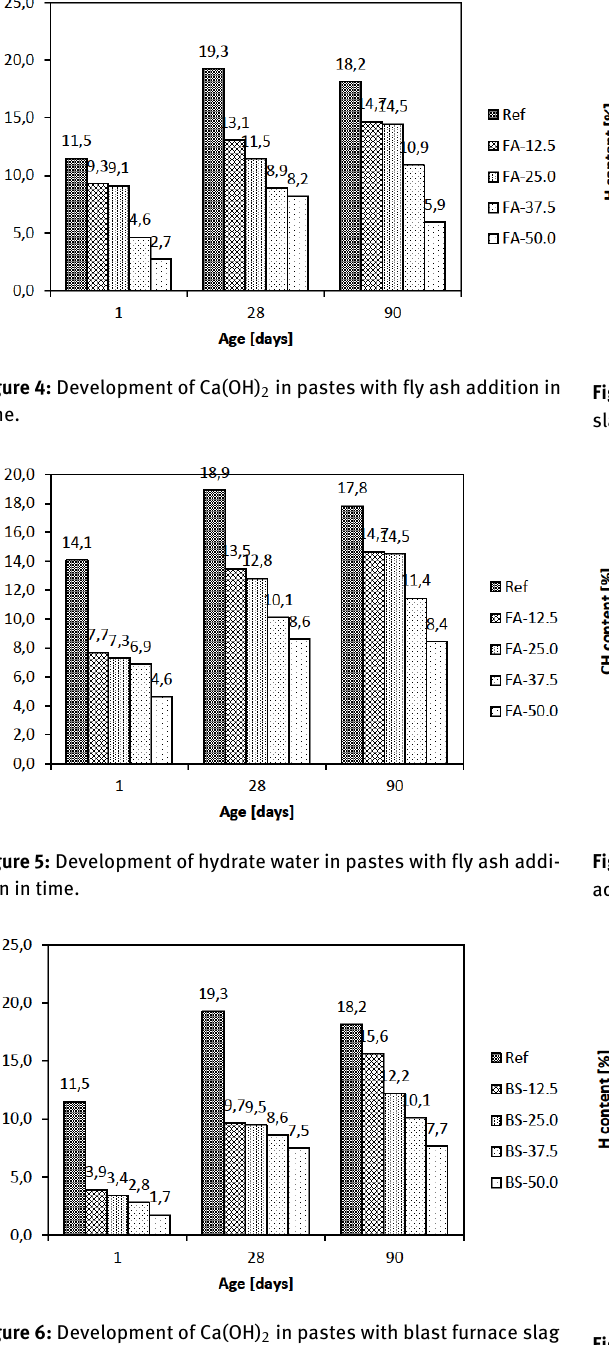
Figure 9: Development of hydrate water in pastes with ceramic powder addition in